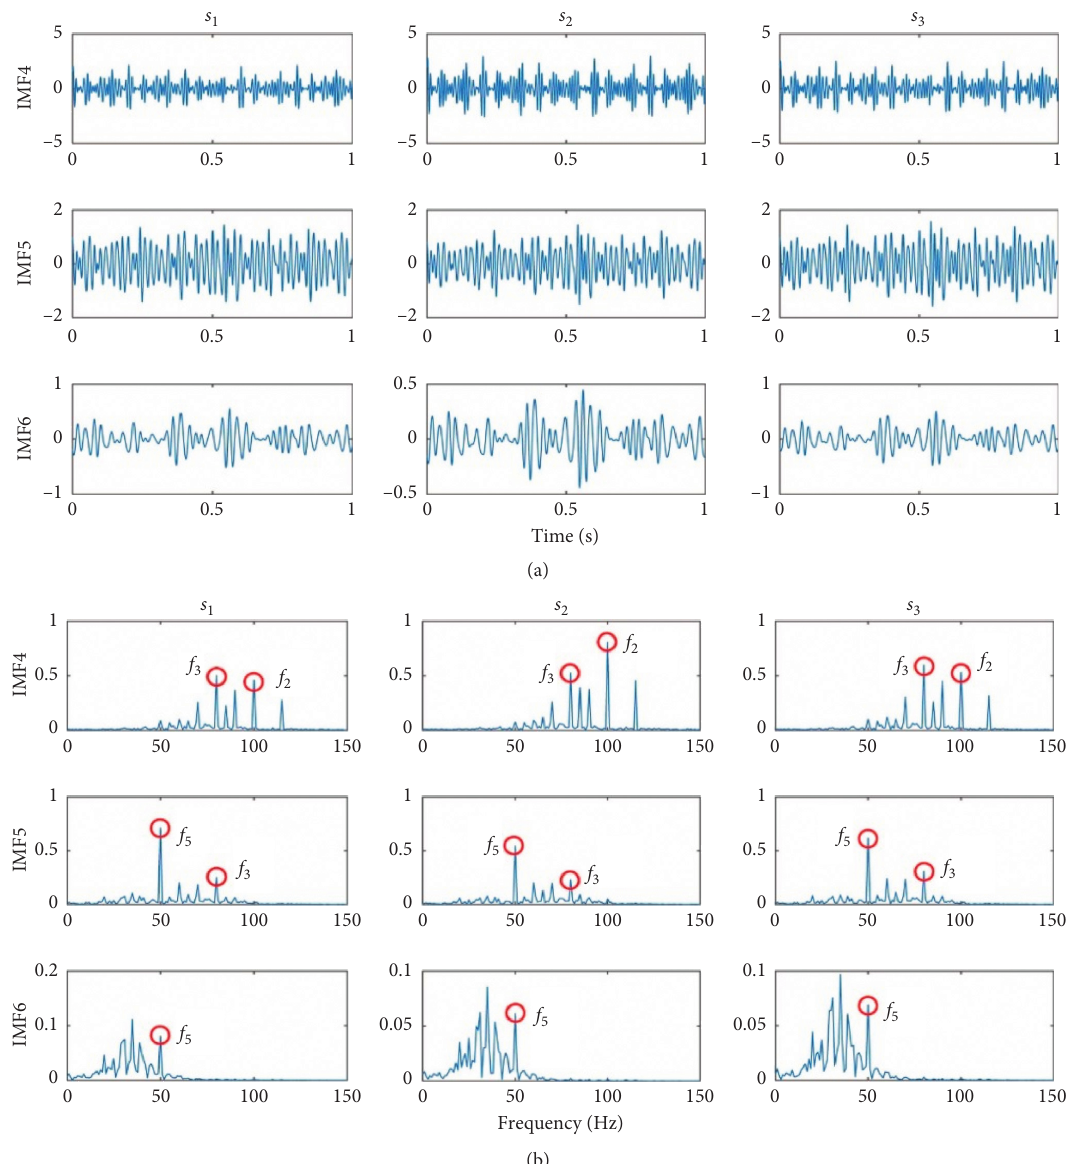
Figure 3: The decomposition results by NAMEMD (IMF4–IMF6). (a) Time domain. (b) Frequency